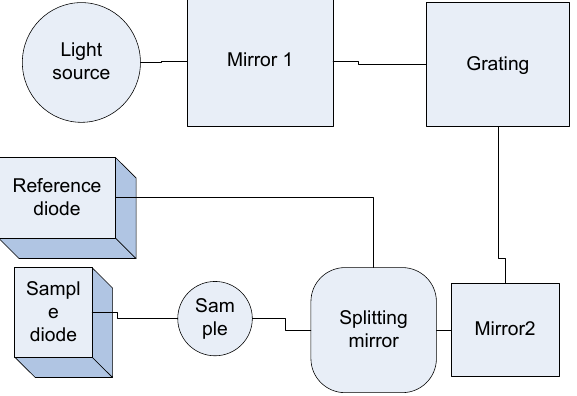
Figure 1. block diagram of double beam spectrophotometer